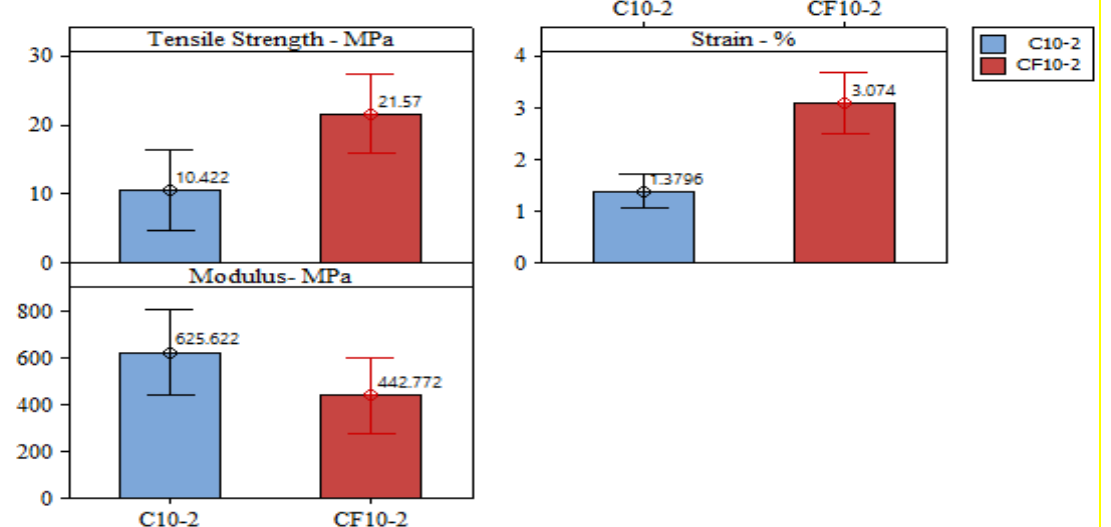
Fig. 8: Tensile Properties for Composites C10-2 (bagasse fiber reinforced) and CF10-2 (bagasse-cotton fabric reinforced